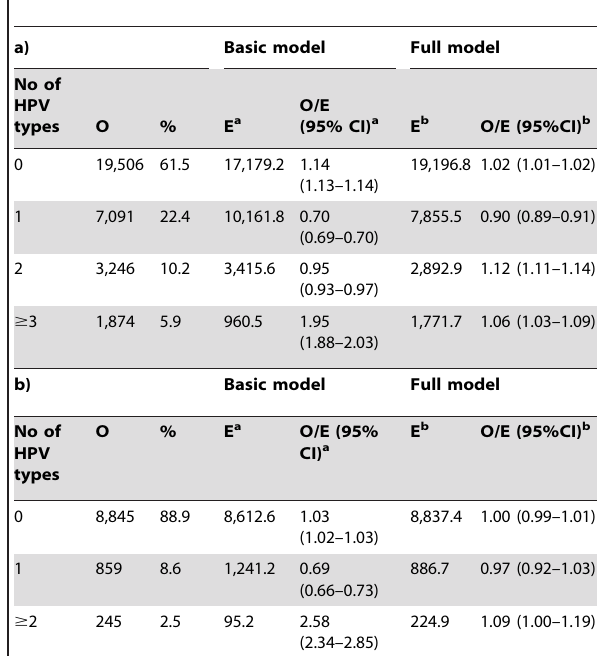
Table 1. Observed-to-expected ratio of multiple human papillomavirus infections, according to two models, in women (a) and men (b),